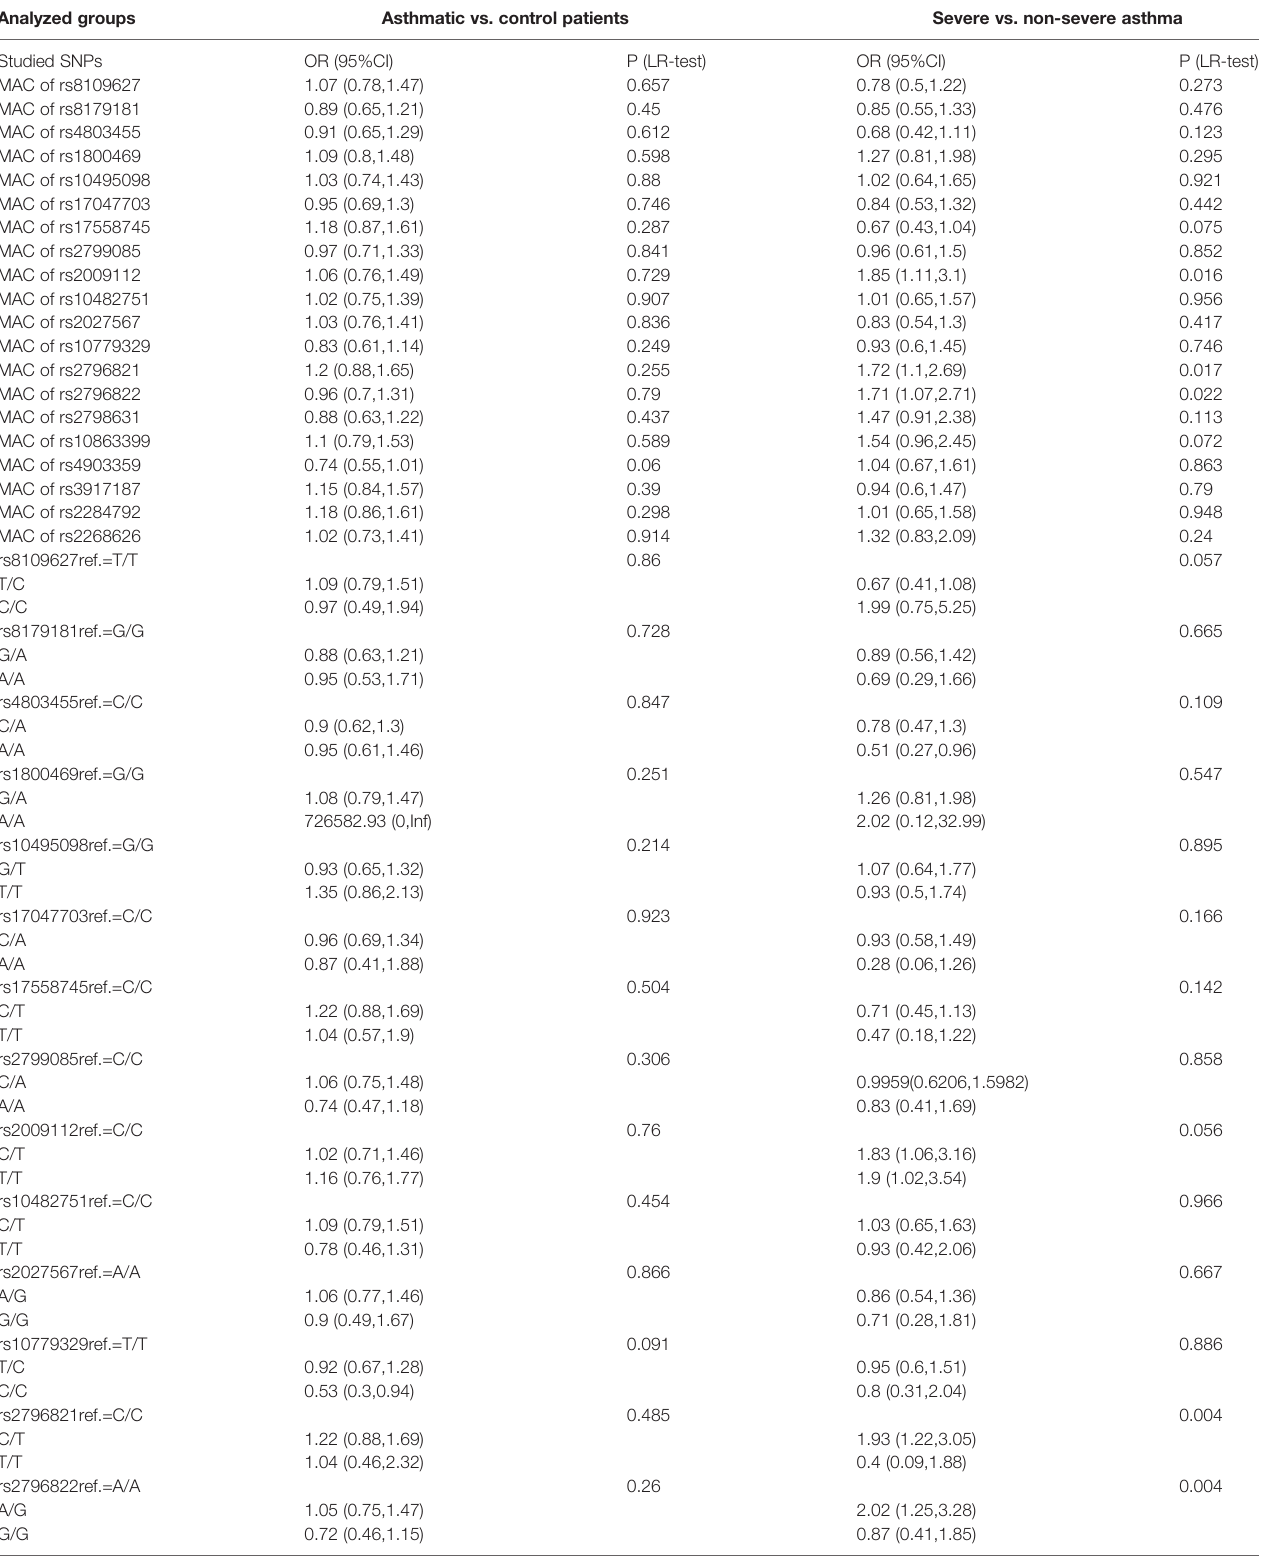
TABLE 4 | Univariable analysis with odds ratios (OR) for minor allele carriers (MACs) and particular genotypes in comparison with reference (ref., most common) genotype. Analyzed